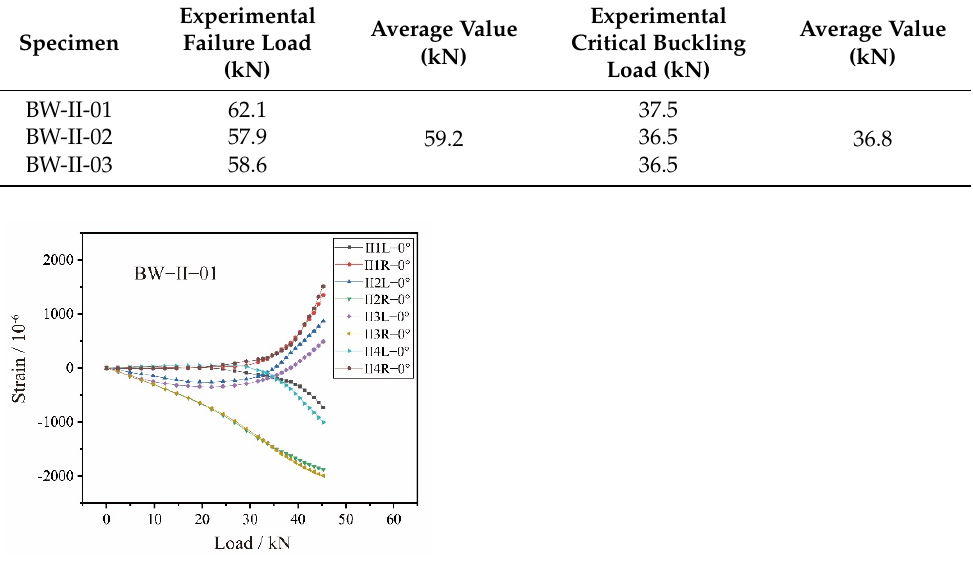
Table 5. Experimental results of the failure load and critical buckling load—the PWF composite beams of BW-II.